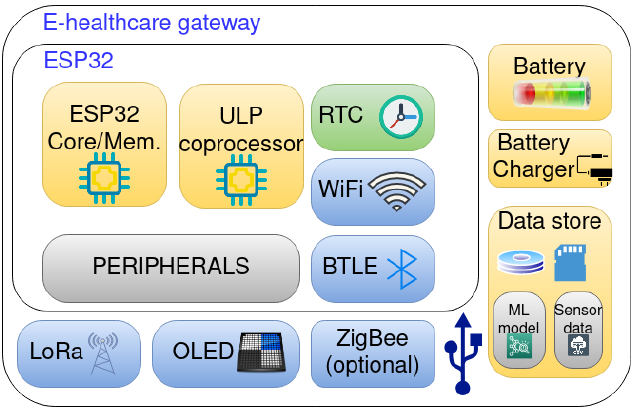
Figure 4. E-healthcare gateway